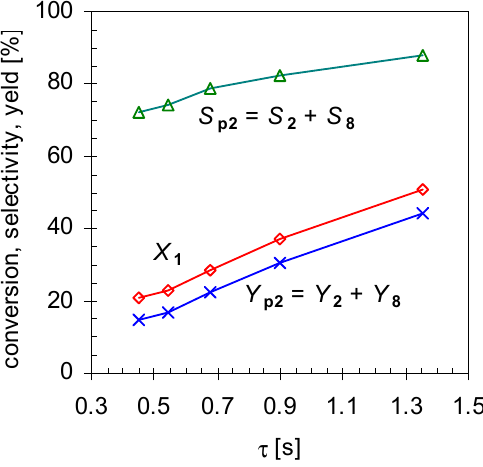
Figure 5. Effect of residence time τ on conversion ( X ; triangles) and yield for products from pathway I ( Y (S p2